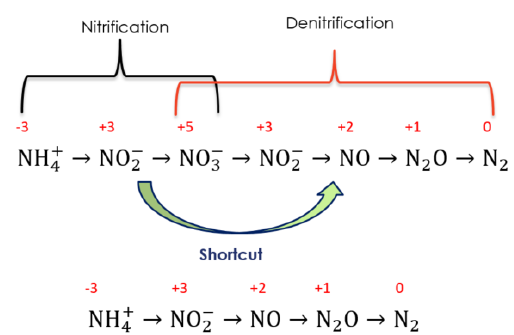
Figure 2. Nitrification, denitrification, and the shortcut mechanism illustrated with oxidation states of nitrogen.